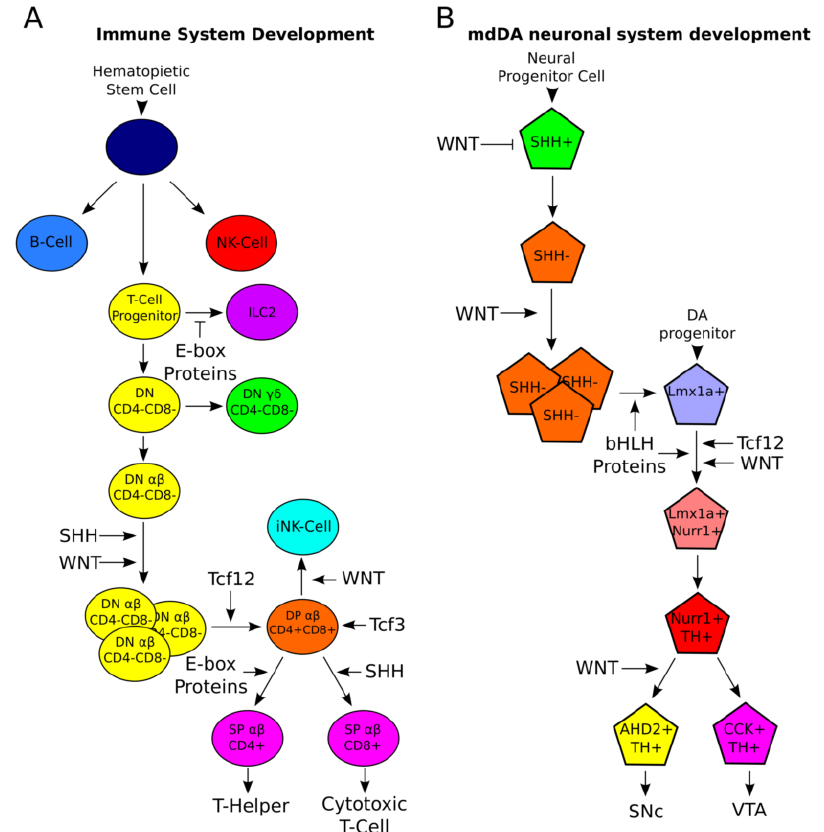
Figure 3. Development of the di ff erent subsets of the immune system. ( A ): Schematic representation of the development of the immune system. All di ff erent cell-types of the immune system arise from the same hematopoietic stem cell lineage. From these cells, the first three subsets in the immune system are derived: B-cells, T-cell progenitors, and NK-cells. T-cell progenitors can become innate lymphoid cells (ILC2), a fate repressed by E-box proteins expressed in T-cell progenitors, or further develop into double-negative (DN) γδ cells that become part of the innate immune system, and DN αβ cells that develop into CD4 + CD8 + DP cells. High levels of WNT-signaling prime CD4 + CD8 + DP cells to become innate natural killer cells (iNK), whereas E-box proteins and SHH signaling drive these cells into a CD4 + or CD8 + single-positive (SP) T-cell-fate, respectively. ( B ): Schematic representation of the development of the mdDA neuronal population. Similar to immune system development, all di ff erent cell types in the mdDA neuronal population arise from one group of neural progenitors. WNT- and SHH-signaling are known to be involved in expansion of the progenitor cell pool and further specification into DA neurons. Similar to immune system development, later fine-tuning into the di ff erent molecular subsets is regulated by bHLH and E-proteins, like Tcf12 , but also by signaling cascades like WNT. Considering the similarities between the development of these systems, molecular mechanisms involved in the development of the immune system may hold clues for the development of the mdDA neuronal population and vice versa. Beside these three categories of immune cells, the T-cell lineage further specifies into different subsets of T-cells. T-cell progenitors specify into T-cells via several intermediate steps, or innate lymphoid cells (ILC2), a cell-fate that is actively repressed by E-box proteins expressed in T-cell progenitors, thereby favoring a T-cell cell-fate [113]. The first sub-division in T-cell formation is the division in the αβ cell lineage and the γδ cell-lineage from double-negative (DN) T-cell precursors that do not express CD4 or CD8 on their membrane (Figure 3A) [109,115]. αβ T-cells are most abundantly present in the population of circulating T-cells, whereas γδ T-cells are present in lower numbers and mainly in areas that are exposed to the exterior, like the gut [115]. γδ T-cells are part of the innate immune system and are generated upon